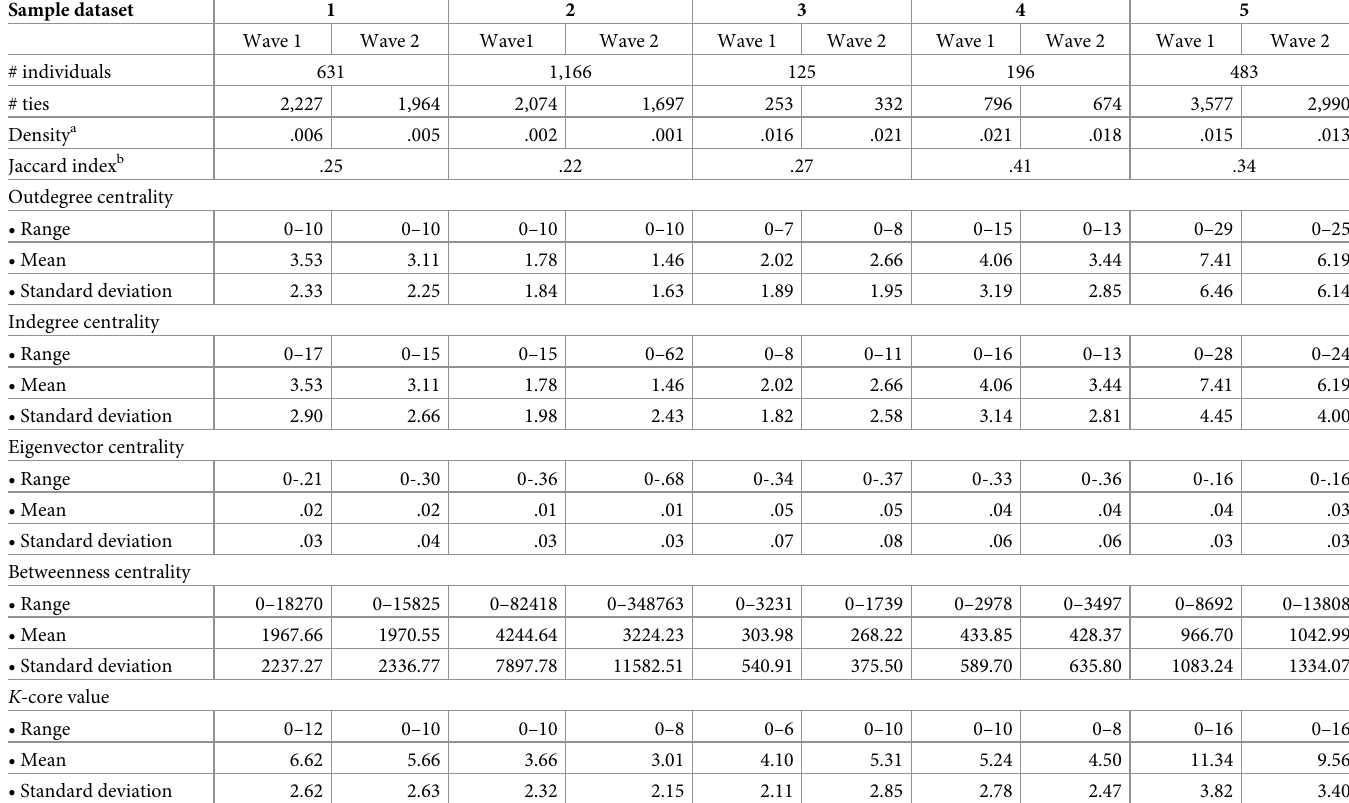
algorithm [48] in Fig 2, with circles of colors red, light green, cyan, and violet indicating increasing smoking frequency and color white indicating missing values. In Fig 2A, both non- smokers (i.e., red circles) and smokers (i.e., circles with colors other than red) in sample Table 2. Network statistics from the five sample datasets. Sample